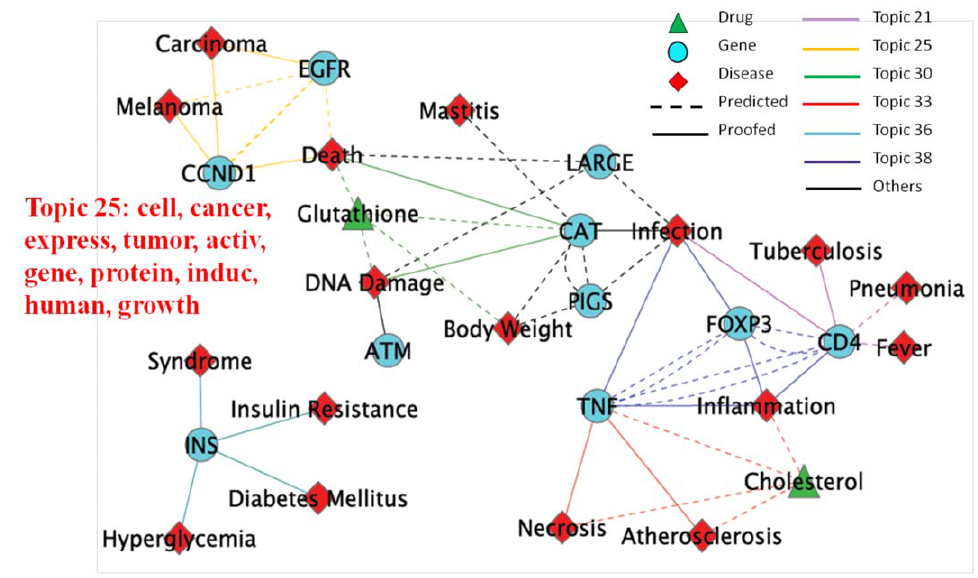
Figure 4. An illustration of bio-relationships generated from selected topics.